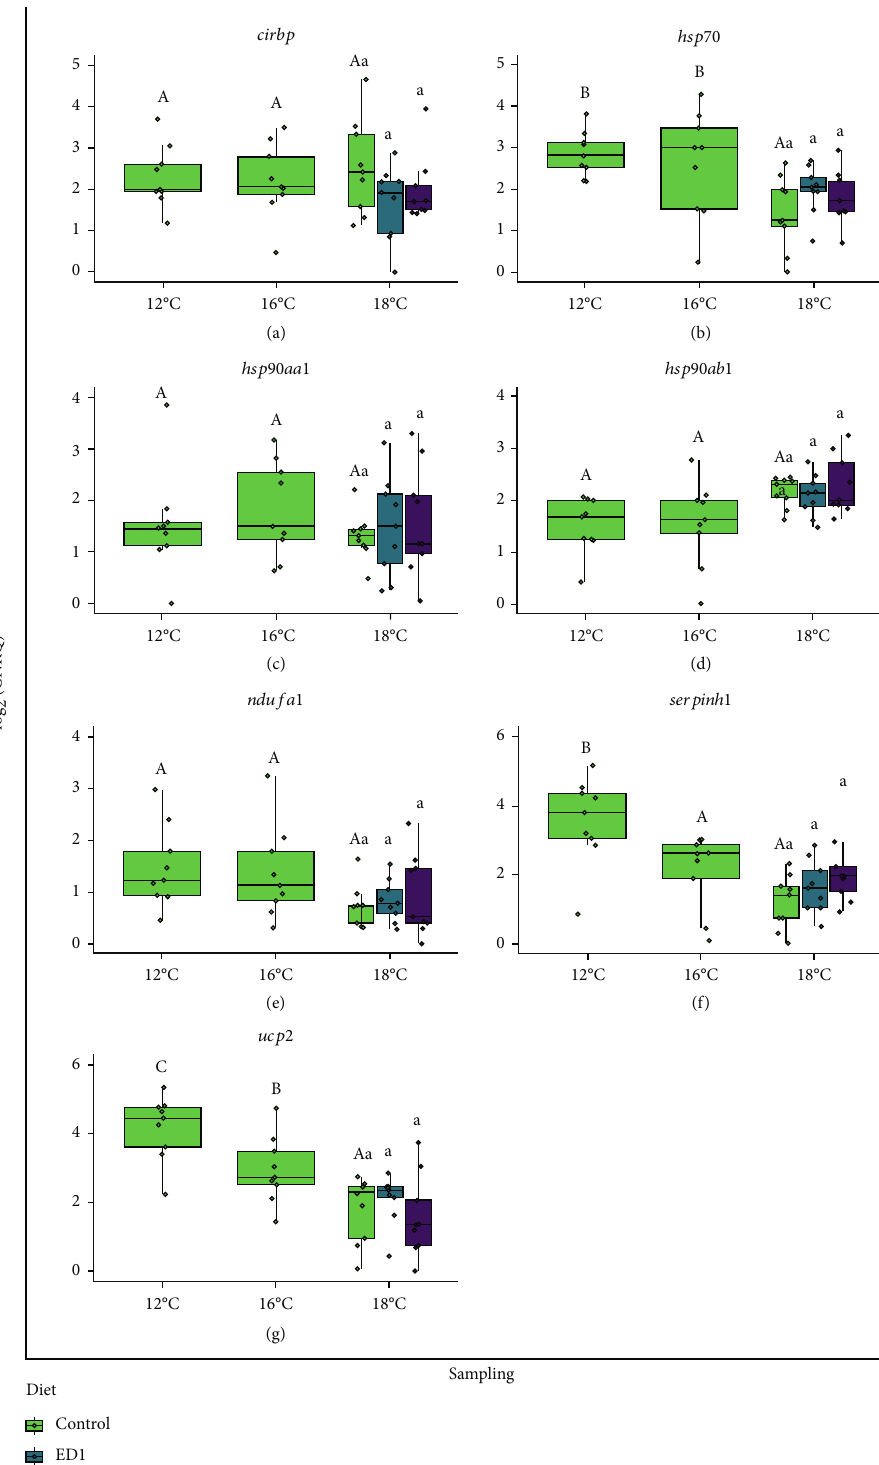
Figure 4: Expression levels of 7 transcripts with roles in responding to heat stress [ cirbp (a), hsp70 (b), hsp90aa1 (c), hsp90ab1 (d), ndufa1 (e), serpinh1 (f), and ucp2 (g)] in the liver of female triploid Atlantic salmon sampled at 12, 16, or 18 ° C and provided di ff erent amounts of dietary cholesterol. Calibrated normalized relative quantities (CNRQs) were compared by one-way ANOVA ( p < 0 : 05 ; n = 9 per sampling/ diet). Upper case letters denote signi fi cant di ff erences between samplings within the control treatment. Lower case letters are the same between diets as no signi fi cant di ff erences were detected at 18 ° C. In all cases, the letter “ A ” signi fi es the lowest value within a